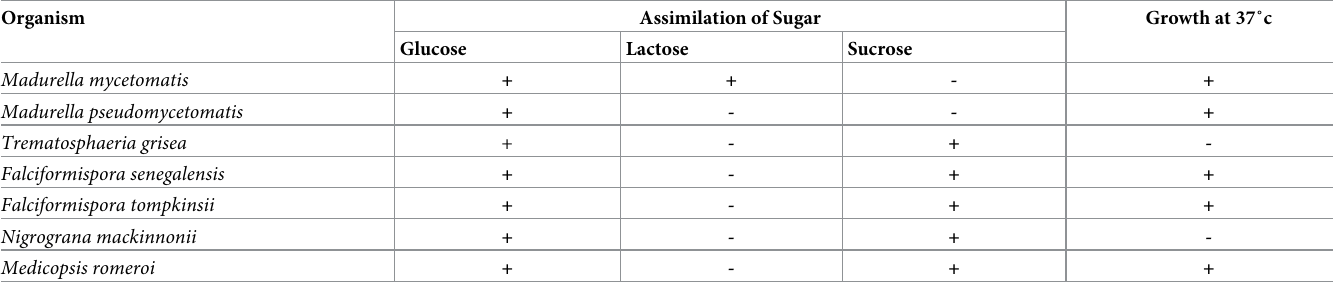
Table 2. Carbohydrates Assimilation test for eumycetoma discrimination.